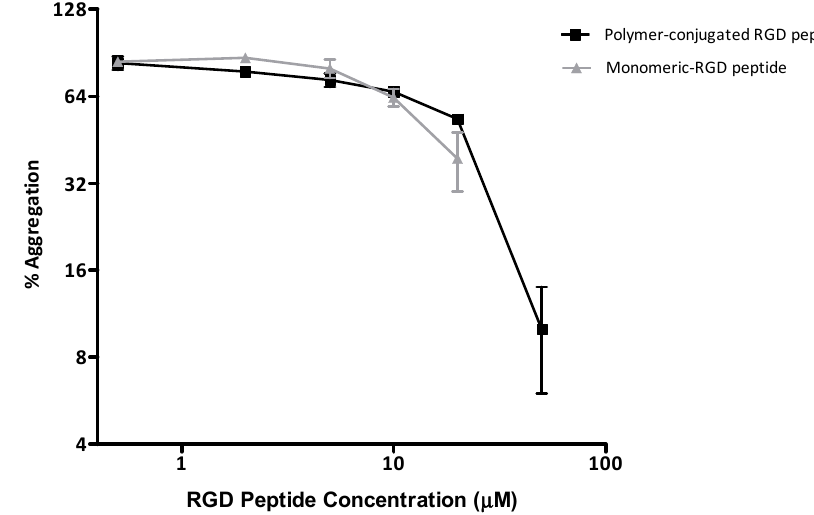
Figure 6. Human washed platelets (300 × 10 3 platelets/ μ L) were incubated with increasing concentrations (0.5, 2, 5, 20 and 50 μ M) of the free (light trace) or polymeric (dark trace) for 5 min at 37 °C in stirring conditions. Following stimulation with TRAP (4 μ M), platelets were assayed for aggregation in light transmission aggregometry. The data are Mean ± SEM of two independent